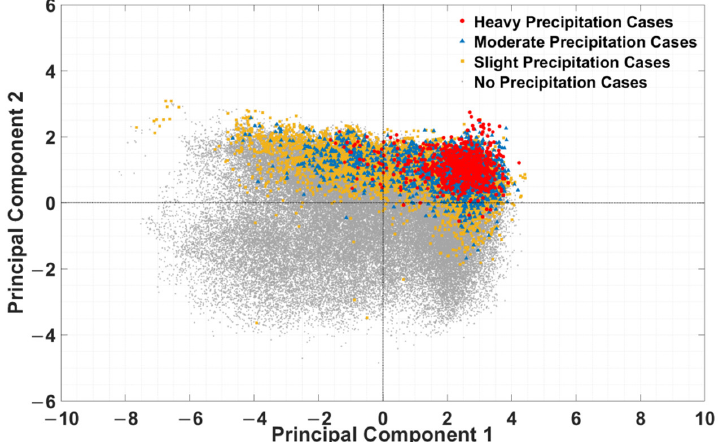
Figure 7. Reduction of the original features to a 2D subspace projected by the first two PC for precipitation discrimination. The red, blue, yellow and gray dots represent heavy precipitation, moderate precipitation, slight precipitation and no precipitation cases.